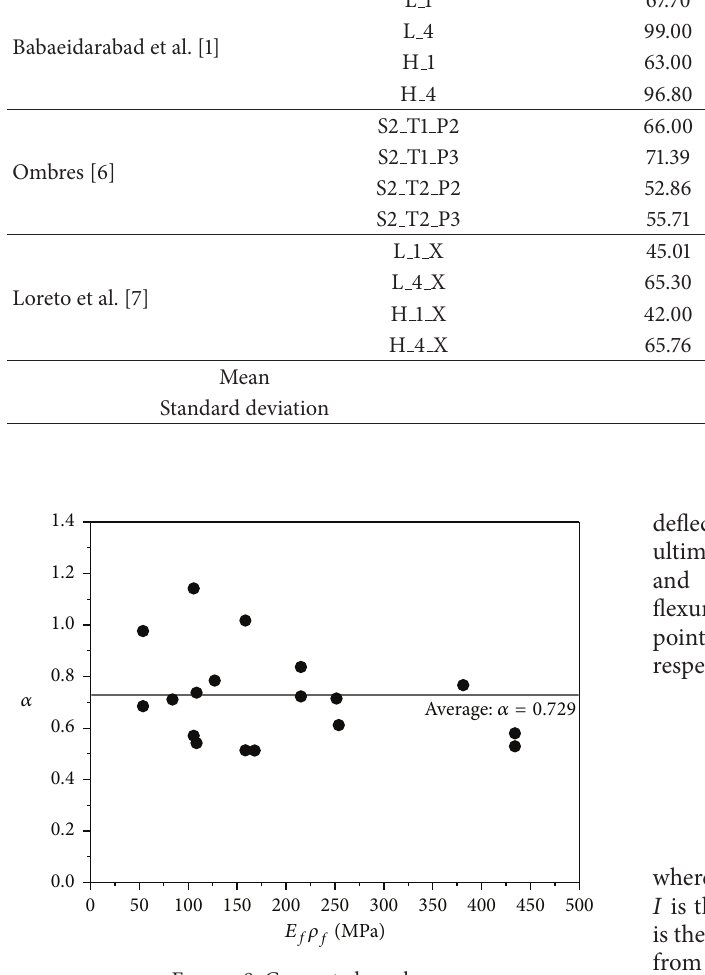
Figure 9: Computed 𝛼